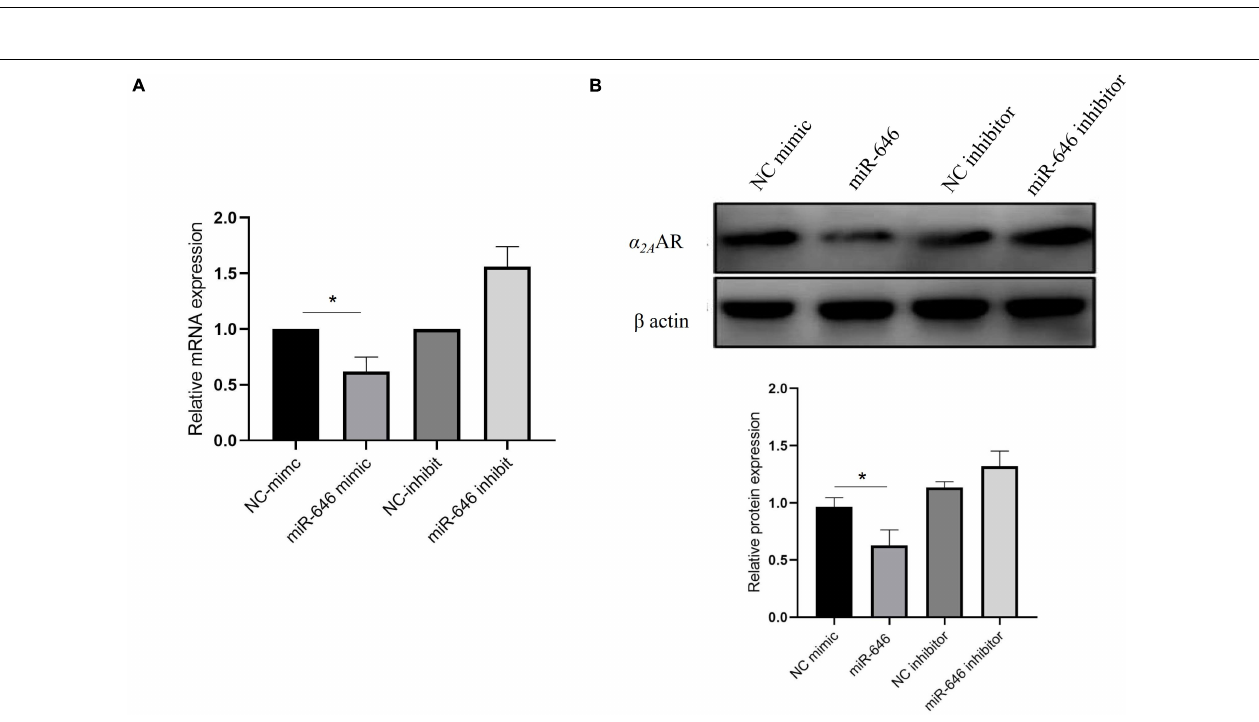
FIGURE 3 | miR-646 inhibited α 2AAR expression. MiR-646 significantly decreases α 2AAR mRNA (A) and protein (B) expression in HeLa cell. The values (mean ± SD from three independent experiments) are relative to NC which was set as 1. * p < 0.05.